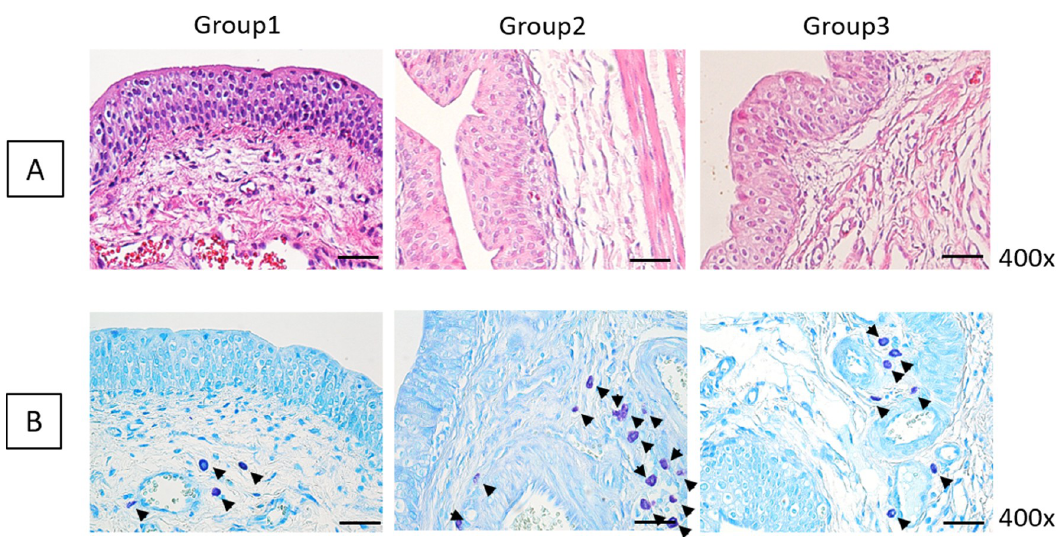
Fig 5. Histological results of direct USC injection into the bladder submucosa (Group 1), transurethral instillation of USC (Group 2) and USC injection via the tail vein (Group 3). (A) H&E histological examination revealed relatively well-regenerated bladder tissues in Group 1 than in other groups. (B) Inflammatory mast cell infiltration was significantly diminished in Group 1.